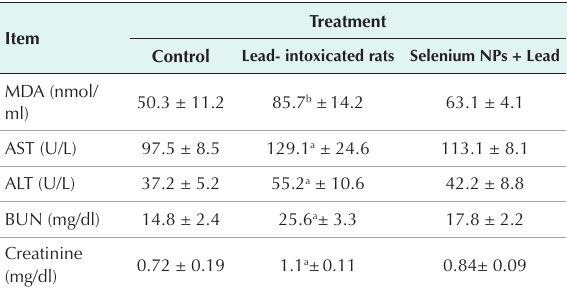
Table 1. Serum Biochemical Indexes and Serum Lipid Peroxidation of Control and Lead-Treated Rats Item